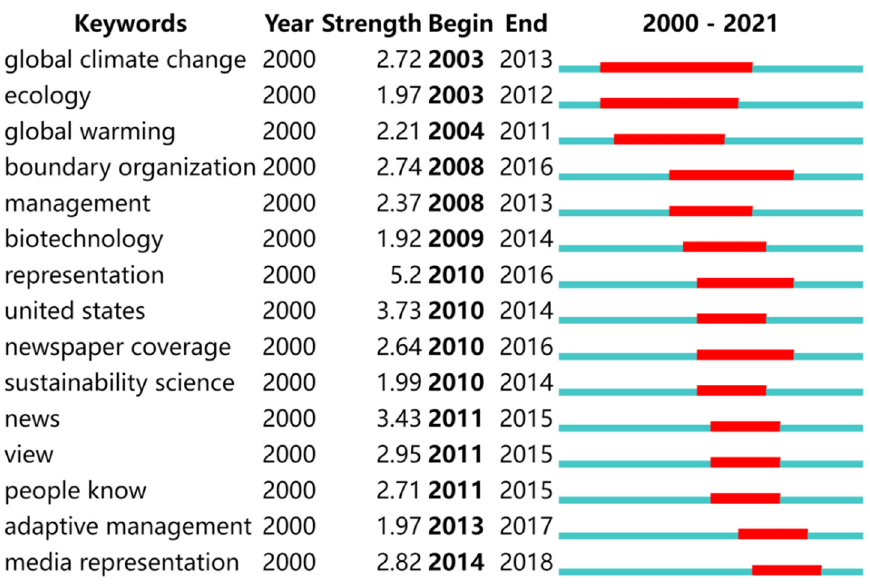
Figure 8. Top 15 keywords with the strongest citation